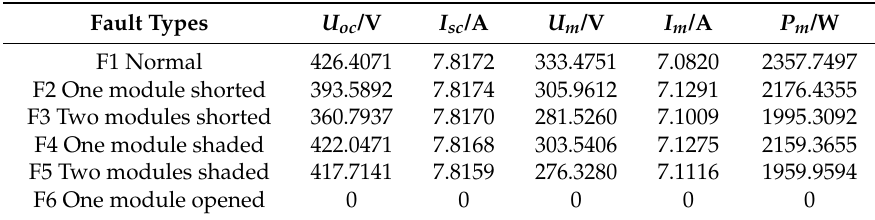
Table 3. Clustering results of typical faults.